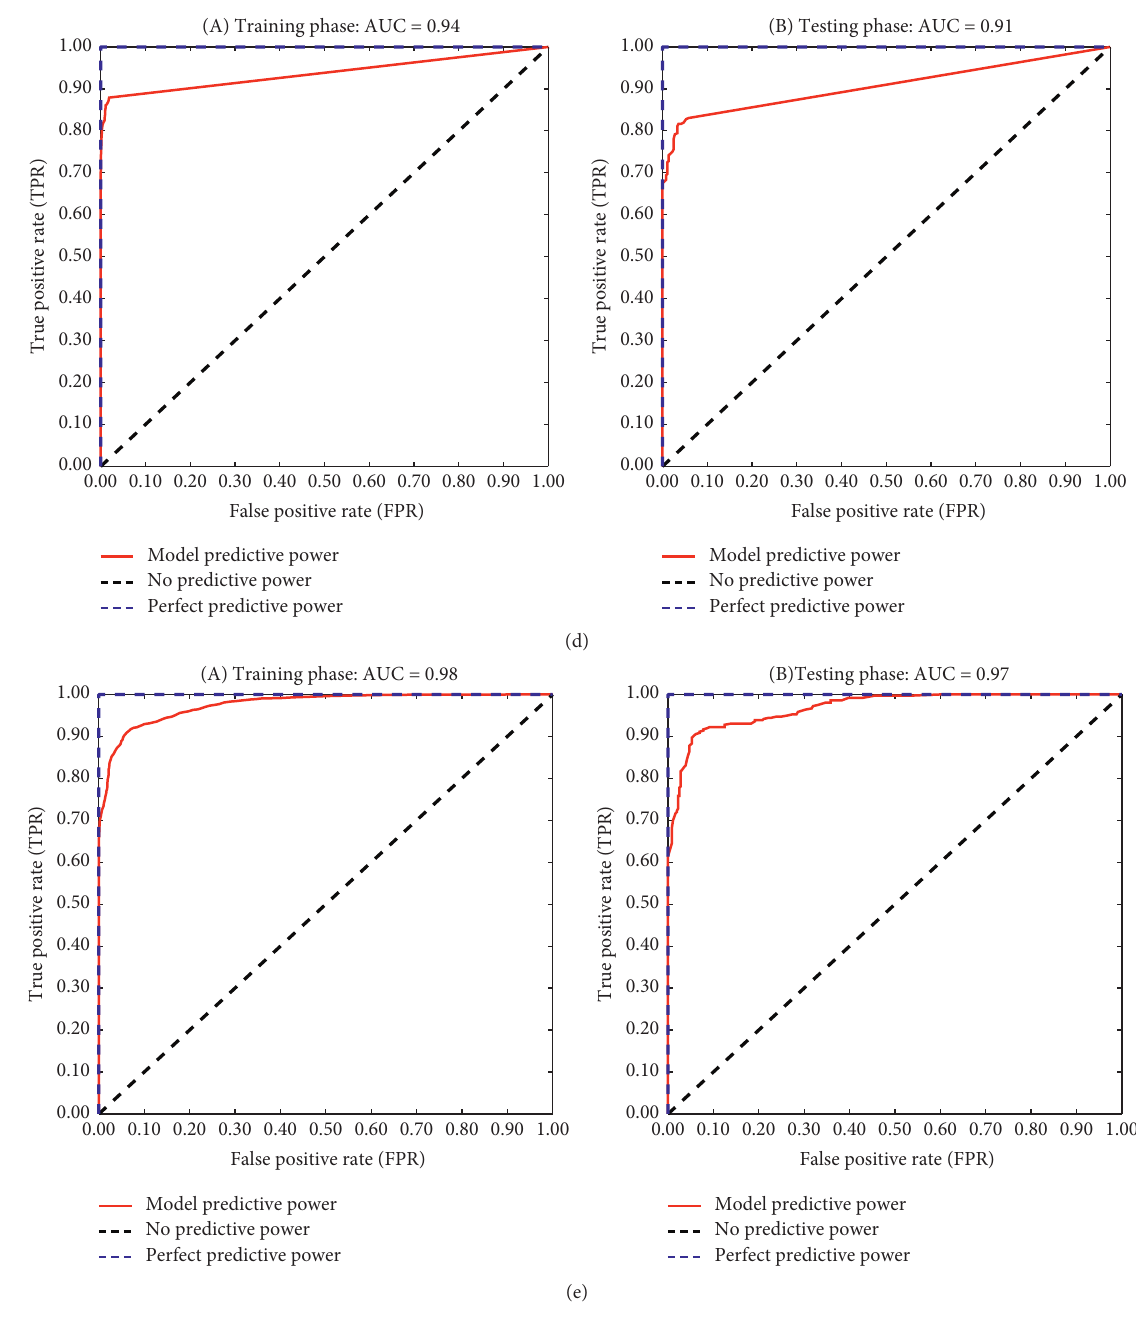
Figure 4: Receiver operating characteristic curves of models: (a) FKNN, (b) ANN, (c) SVM, (d) LSSVM, and (e)